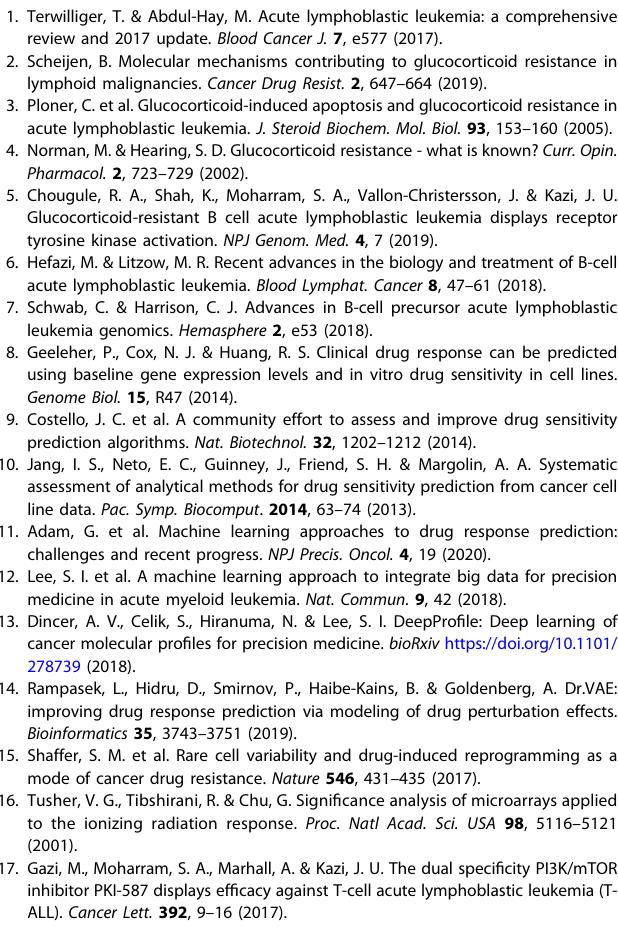
Figure_5e_f.pdf, Synergy_data.xlsx, Upstream Kinase Score_PTK_Figure_2a.png, Upstream Kinase Score_STK_Figure_2b.png, SUP-B15_EC50.pzf.